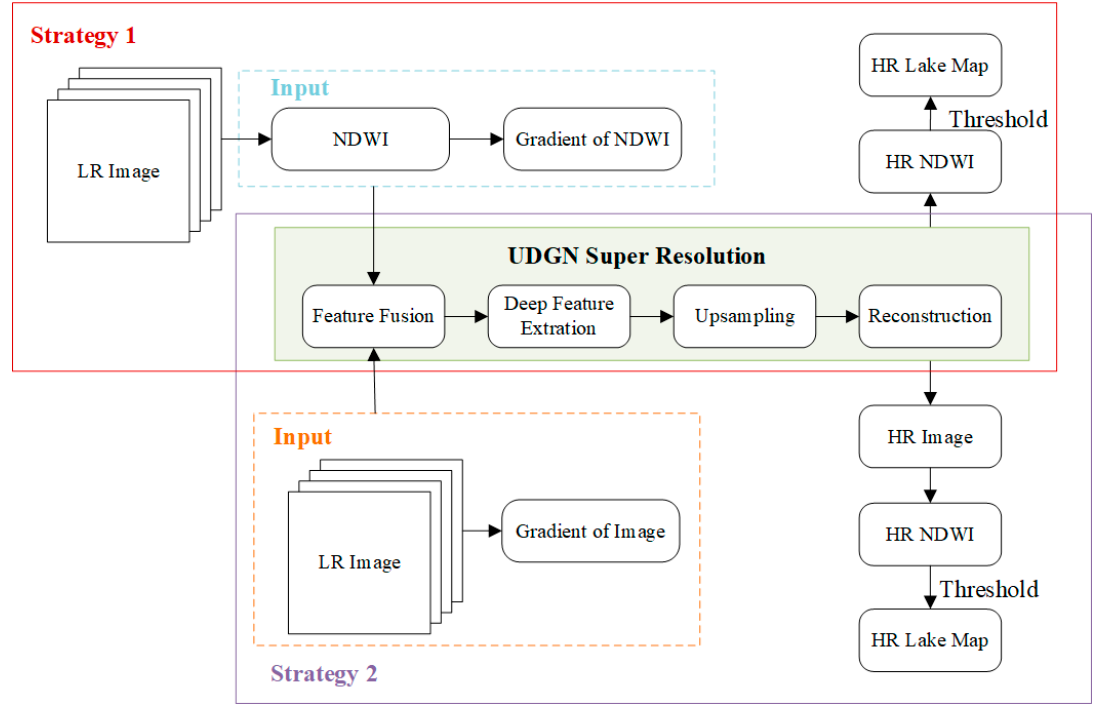
Figure 2. Flowchart of higher resolution lake area extraction (LAE) from remote sensing (RS) images. Two strategies using the unsupervised deep gradient network (UDGN) model are proposed to improve the spatial resolution of the lake area.